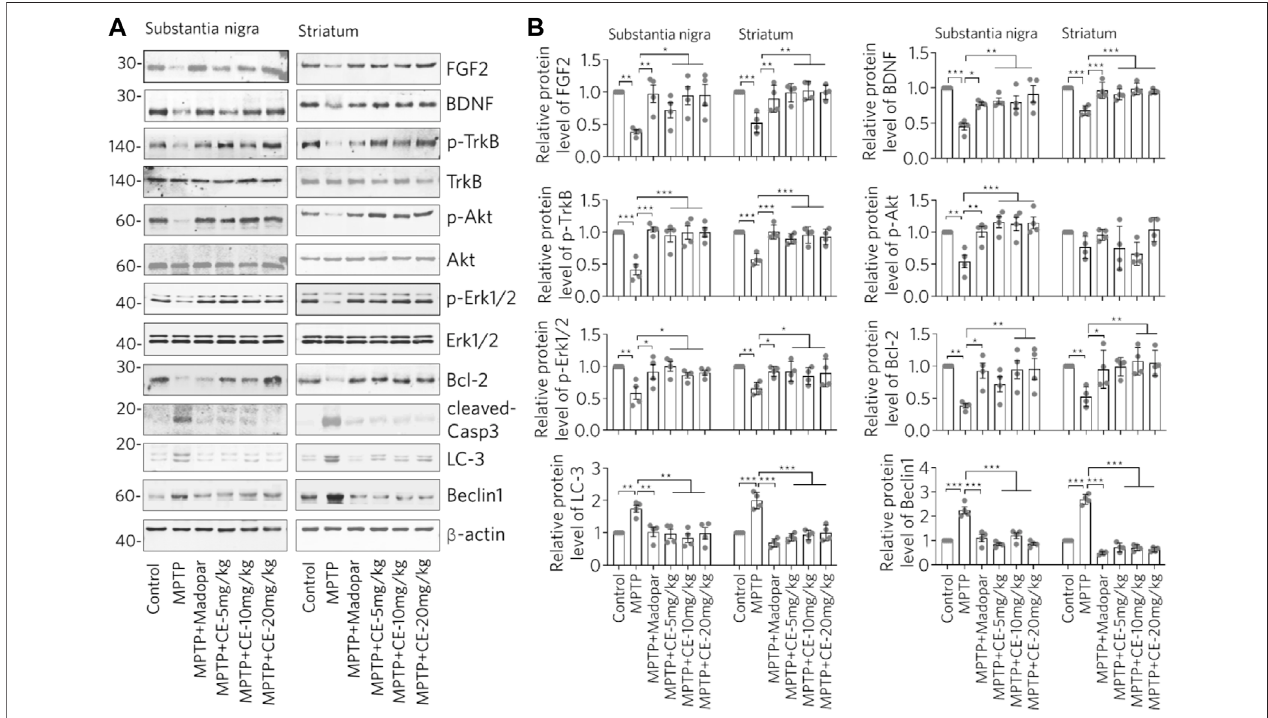
FIGURE 5 | CE maintains the BDNF-TrkB and FGF2-Akt signaling pathways and inhibits apoptosis and autophagy to attenuate MPTP-induced toxicity. (A) WesternblottinganalysisofBDNF,FGF2andtheirmediatedsignalingpathways,aswellasmarkerproteinsforapoptosisandautophagy. (B) Relativeproteinlevelswere calculated from the density of blotted bands and normalized to β -actin. One-way ANOVA with post hoc Dunnett ’ s test, n = 4.